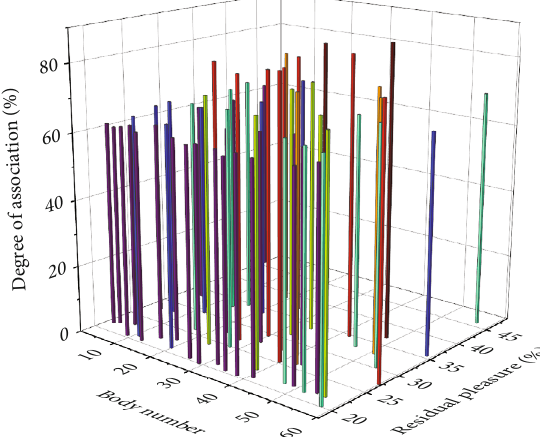
Figure 3: The correlation between object a ’ s residual pleasure and di ff erent